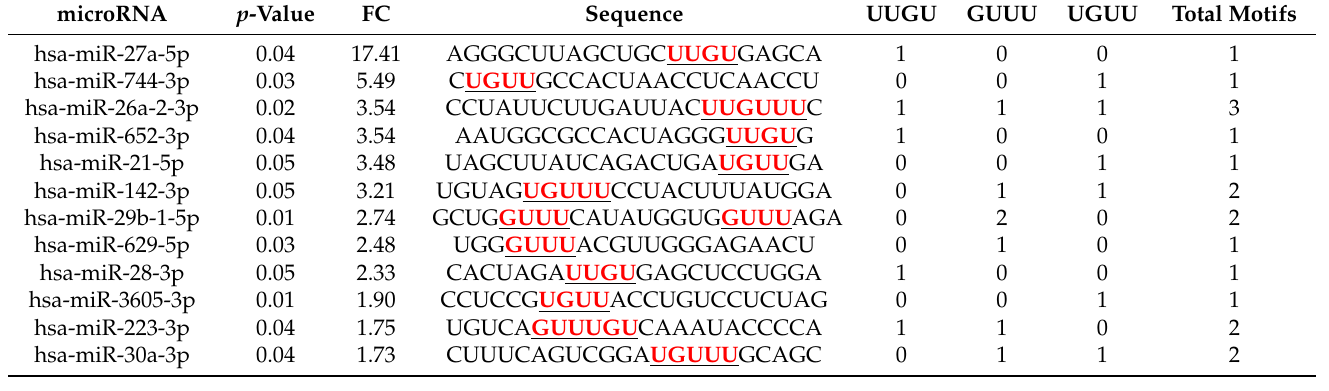
frequencies of each motif in the EV enriched microRNAs compared to the genome-wide set of microRNAs. Table 1. TLR7/8-activating microRNAs are enriched in exosomes from epileptogenic tissue. Mature microRNA sequences are shown with highlighted G/U-rich motifs that activate TLR7/8. The microRNAs are sorted in order of fold change, comparing epileptogenic to non-epileptogenic exosomes.